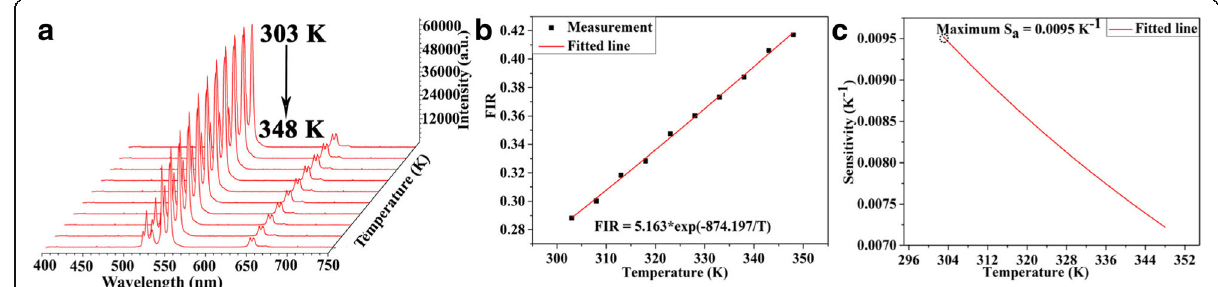
Fig. 9 a 3D up-conversion emission spectra of Ag co-doped microfiber under 980 nm excitation source. b Fitted curves between fluorescence intensity ratio and temperature. c Fitted data between sensitivity (K − 1 ) and temperature (K) of Ag co-doped microfiber